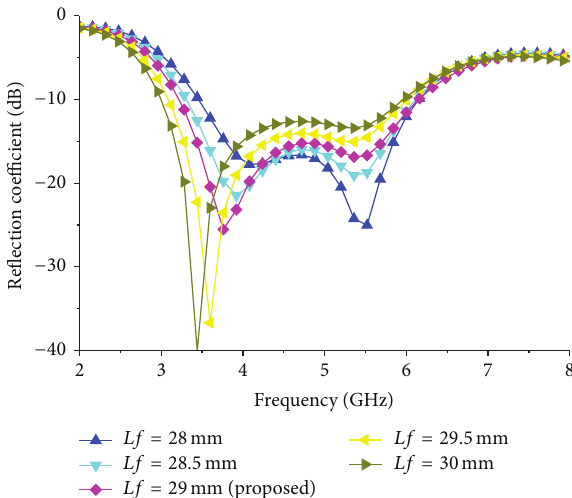
Figure 7: Effect of reflection coefficient for different feed width 𝑊𝑓 .